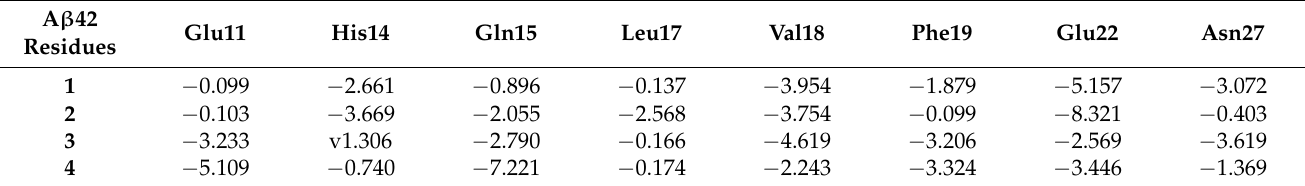
Table 3. MM/PBSA-pairwise decomposition analysis of the binding site residue interaction energies to the ligands (kcal mol − 1